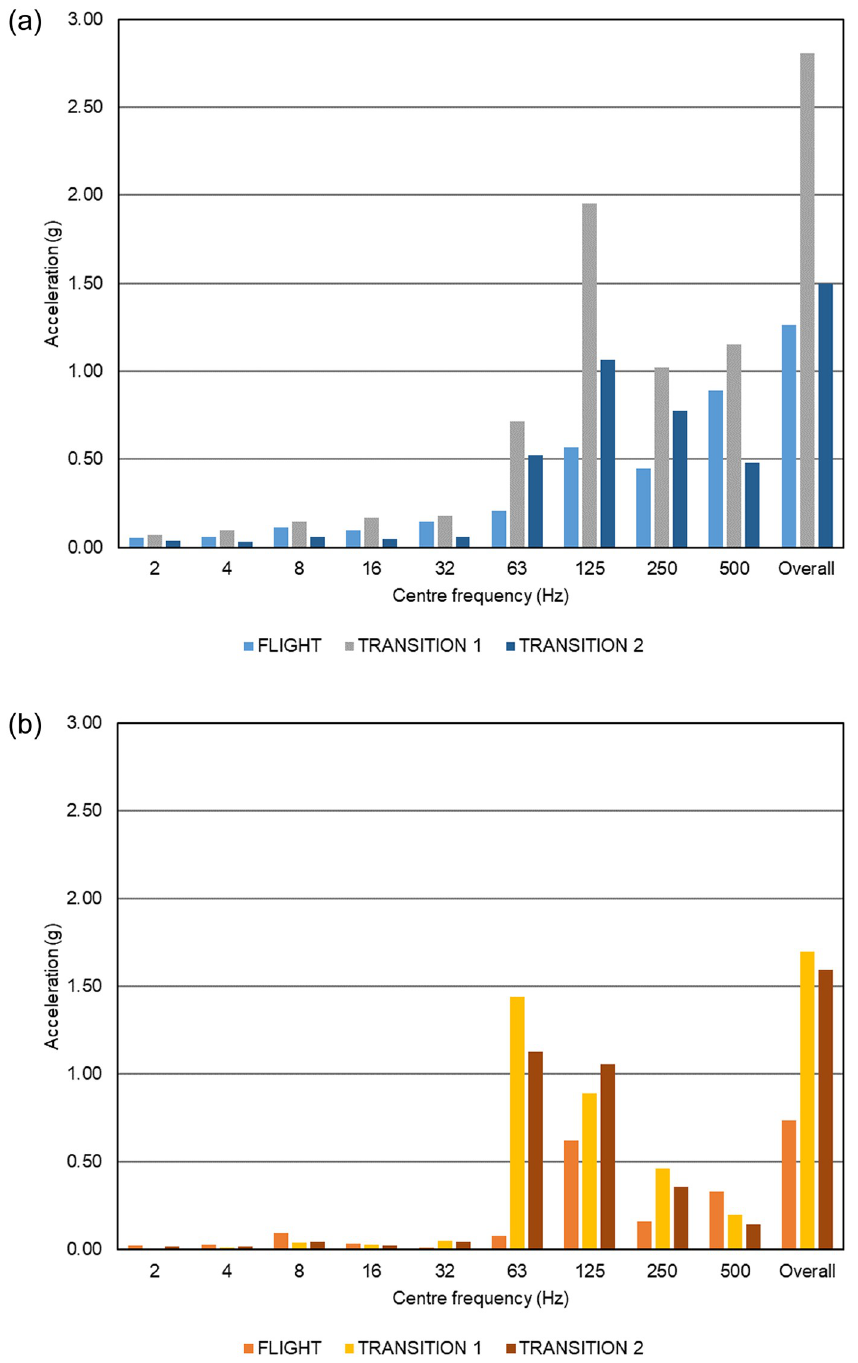
Fig 8. Octave spectra of resultant vibration (a) in the cargo bay of the Skylift V50 (Mugin 5 Pro) and (b) inside the Versapak. Ahmadi et al. [36] found that rituximab samples that were stir-stressed for 30 mins, 200 rpm (1 mg/mL, pH = 7.4) were shown to achieve low levels of sub-visible aggregates ( < 3%), which enhanced dendritic cells maturation and antigen presentation (CD4 + T cells) using fluo- rescent microscopy [36]. Extended periods of stirring, for example up to 120 hours at 600 rpm,